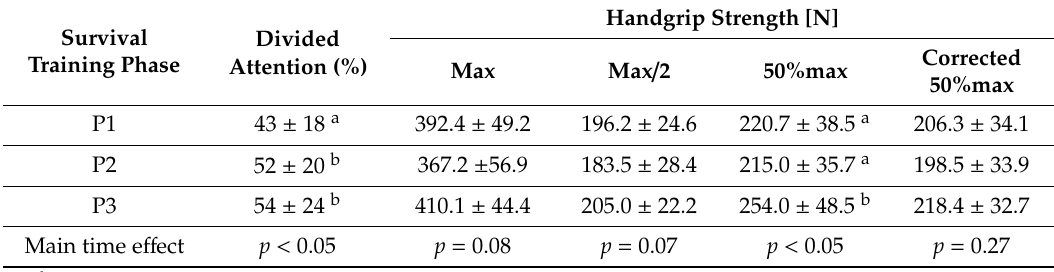
Table 2. Mean values ( ± SD) of divided attention and handgrip strength in special forces soldiers ( n = 15) during the 48-h military survival